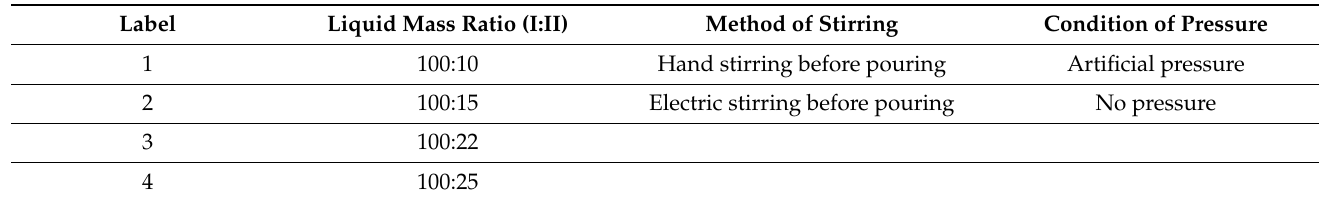
Table 1. Plugging substance curing test amounts based on various